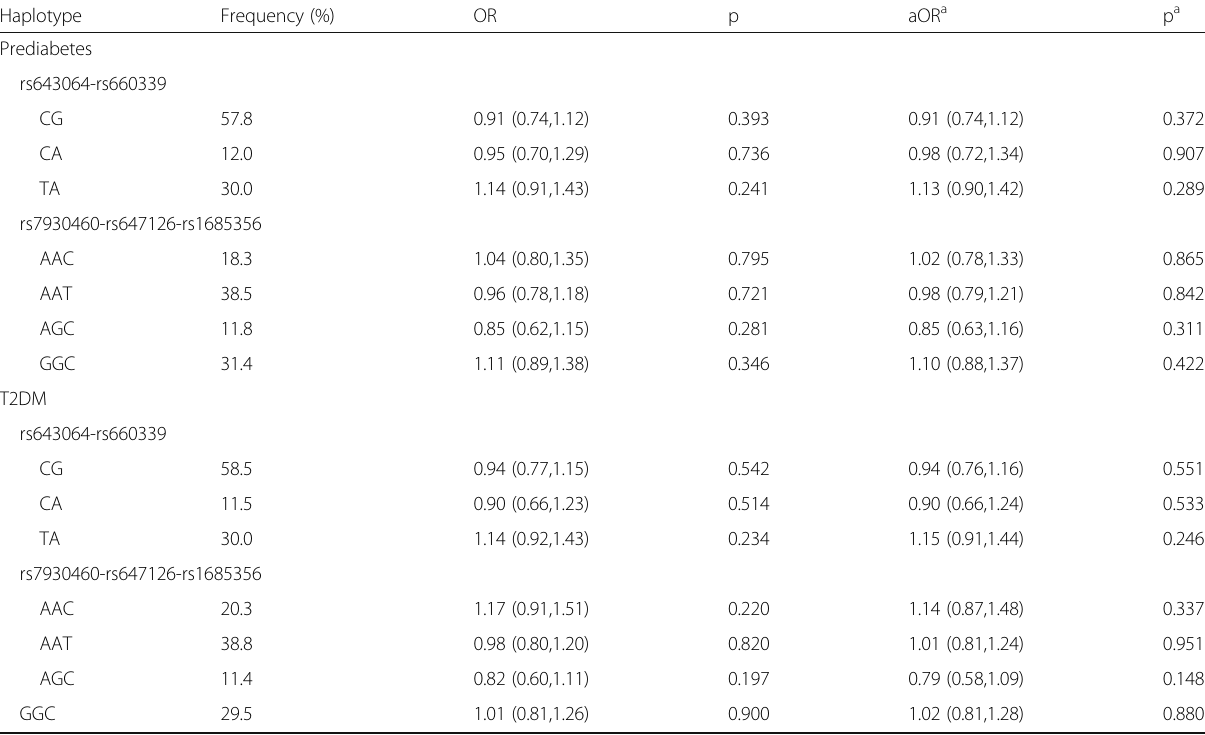
Table 3 Associations of haplotypes with prediabetes and type 2 diabetes (T2DM)